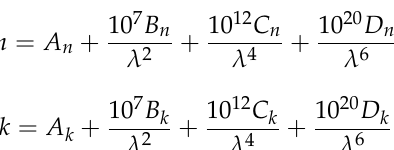
P3HT/G composites. The root mean square errors (RMSE) of the fits are also